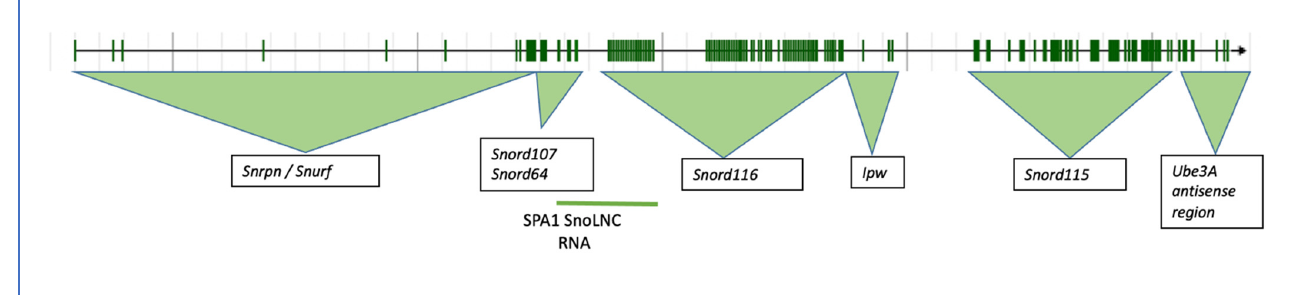
Figure 2. The mouse Snhg14 host gene on chromosome 7B5 and associated loci. The intron/exon structure of the mouse gene was obtained from MGI, ID 1289201.